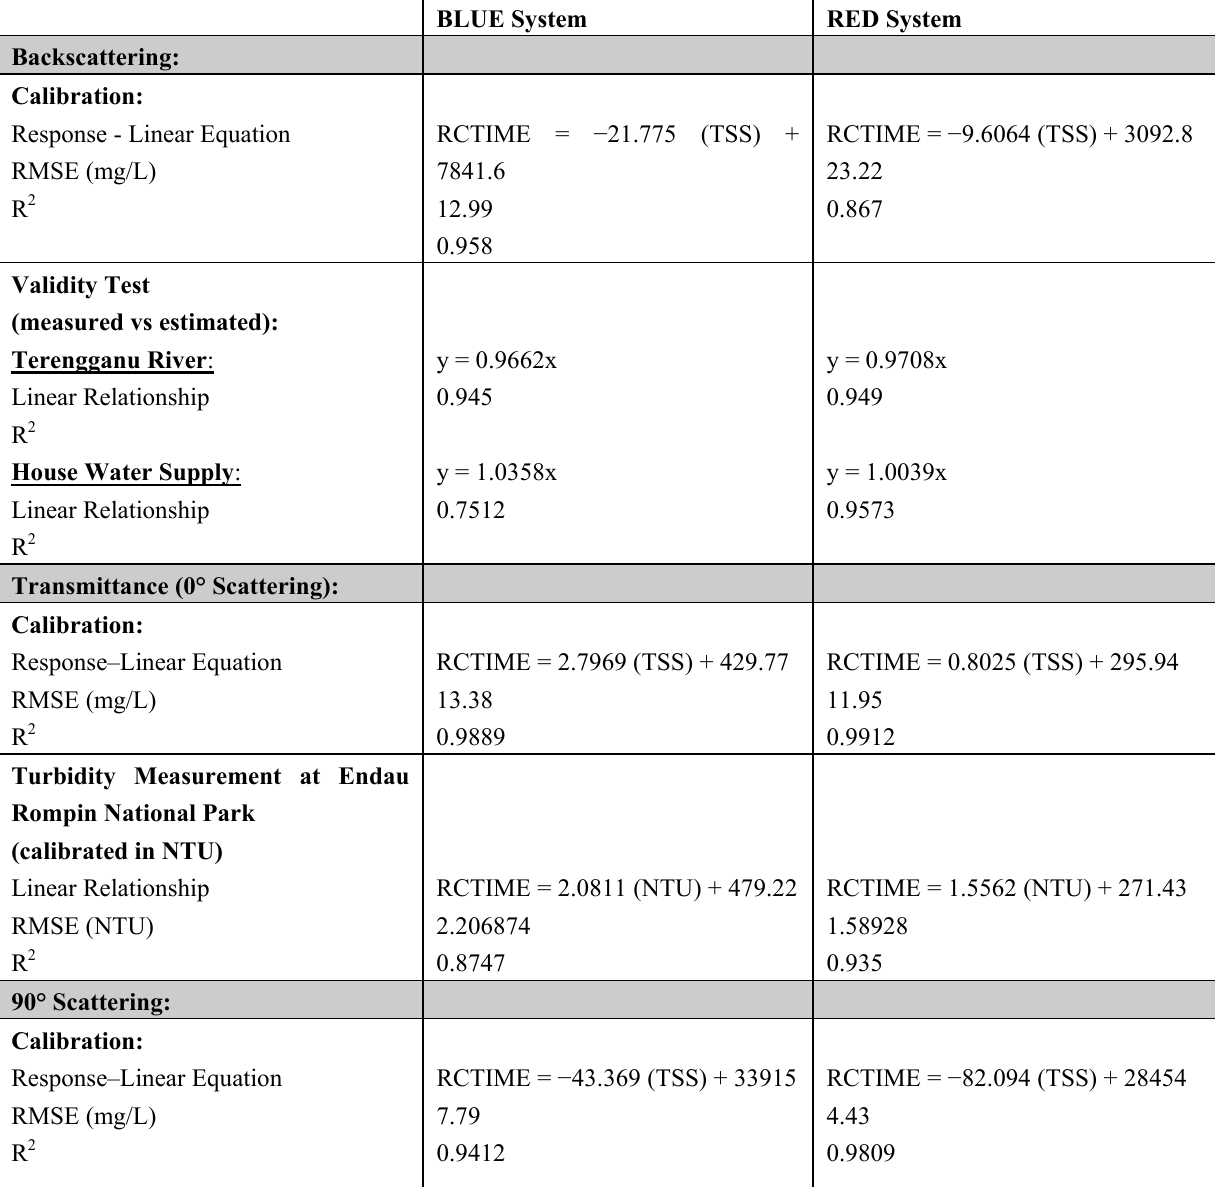
Table 6. Comparison between Results Measured by BLUE and RED